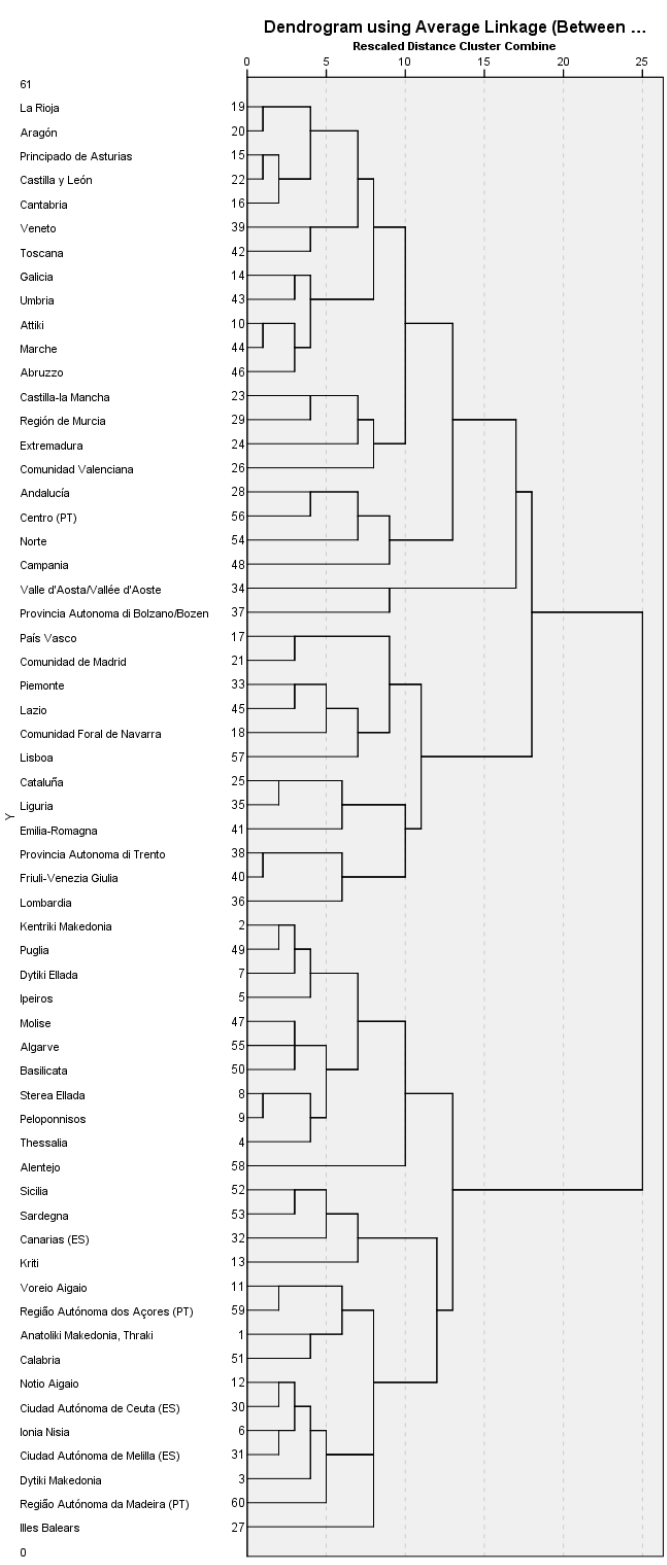
Figure A.3: Dendrogram based on the economic characteristics of the south European regions